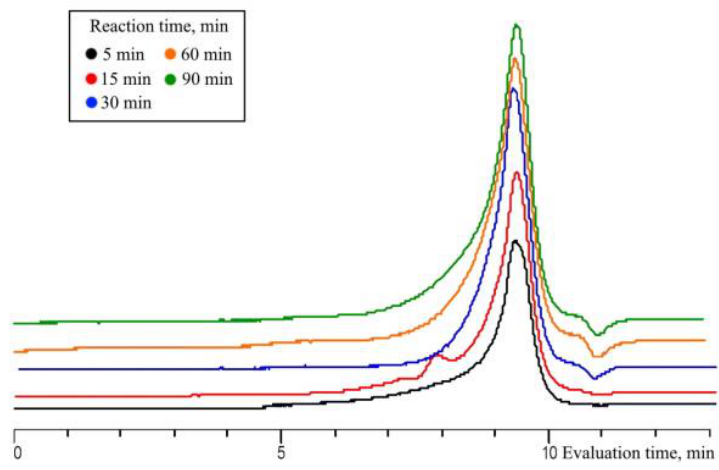
Figure 10. GPC curves of the oligomeric fraction obtained by MTMS MWHP at different radiation times and MTMS/H 2 O molar ratio of 1/1.5, 30 ◦ C, 20 W (Samples 3, 7–10, Table 1).